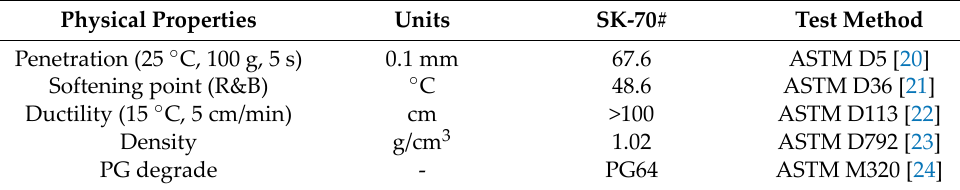
Table 1. Main performance indexes of base asphalt.